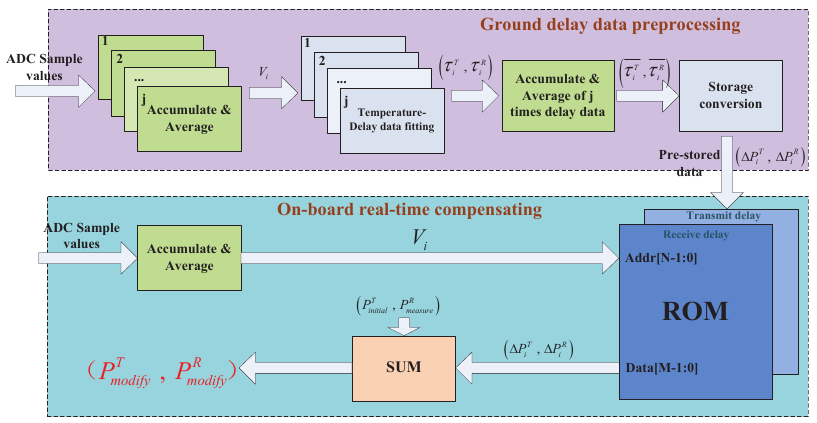
Figure 4. Entire data-processing diagram of the ranging compensation temperature-sensing sensor.